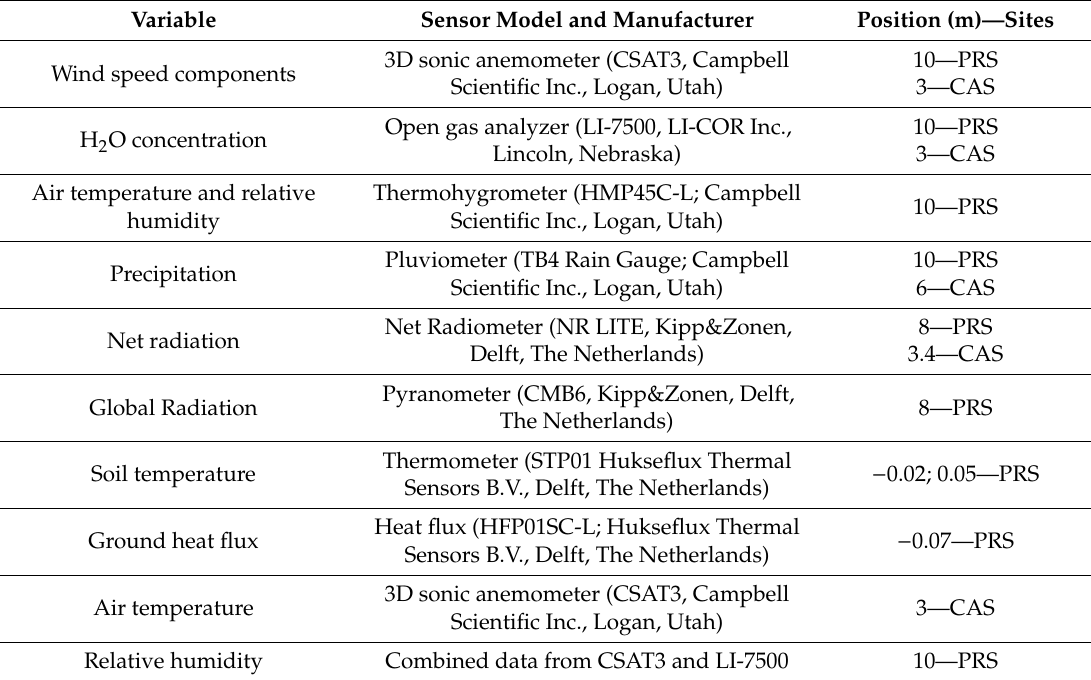
Table 1. Sensors installed at the flux towers used in this